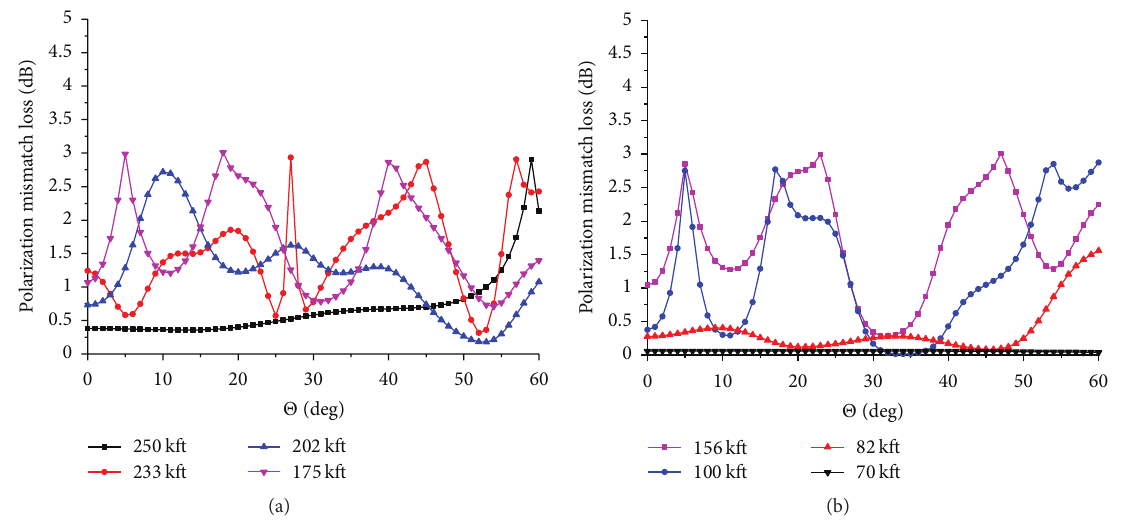
Figure 9: Polarization mismatch loss (plane of phi = 90 deg) at different